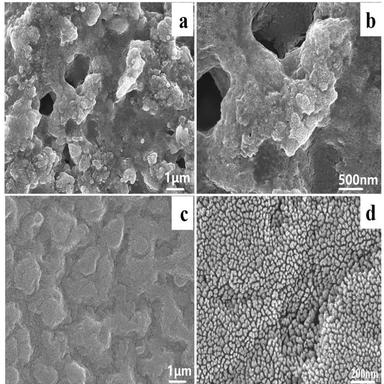
SEM image of the LTO-0.1Cu composite (a) (b) and LTO (c) (d) at 1C after 800 cycles.